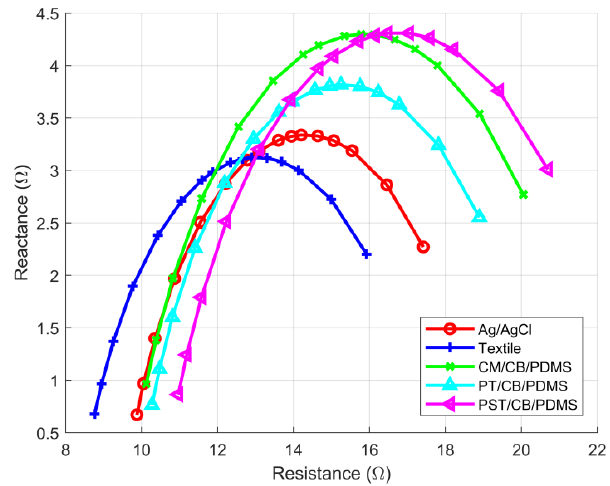
Figure 5. Cole–Cole plots obtained for the five types of electrodes, for a given subject.